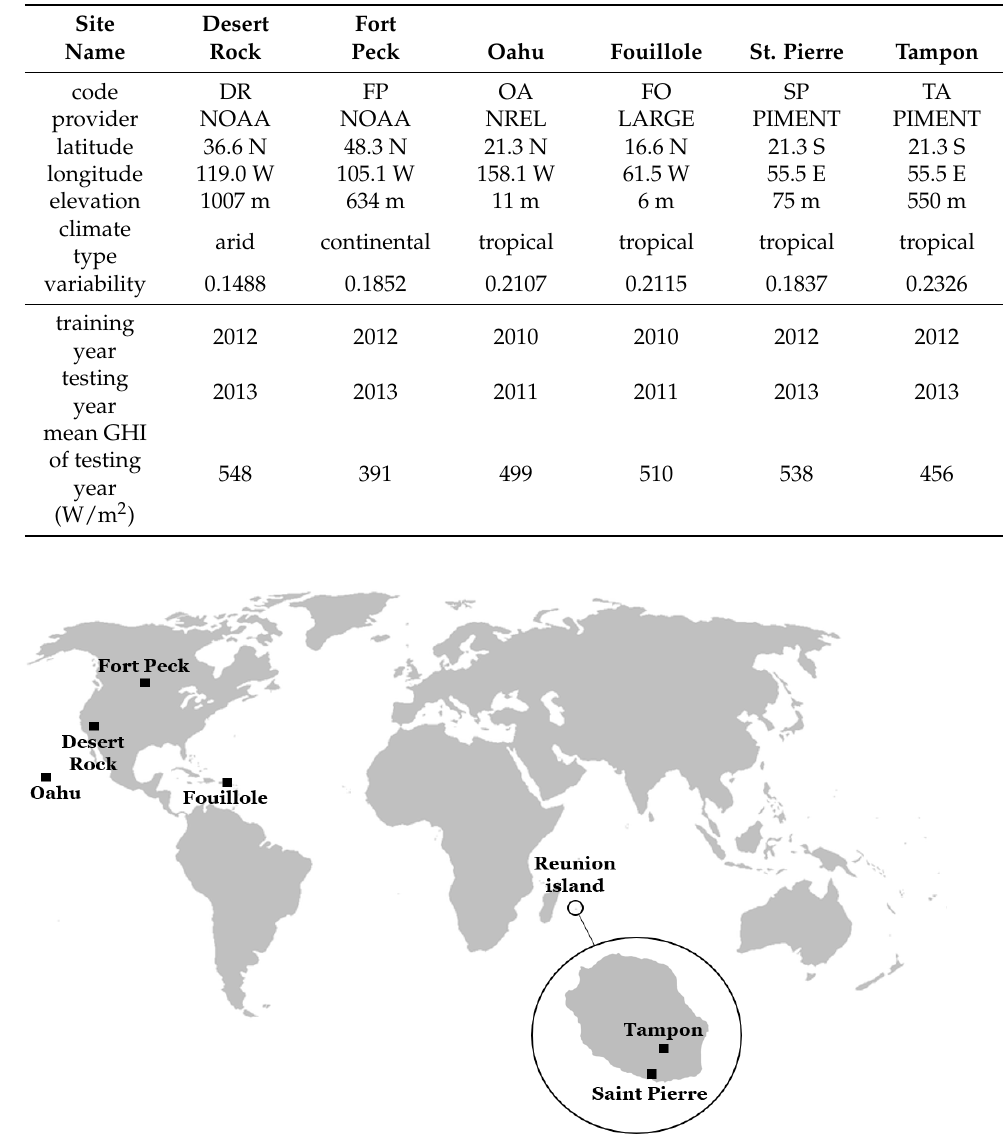
Figure 1. Sites under